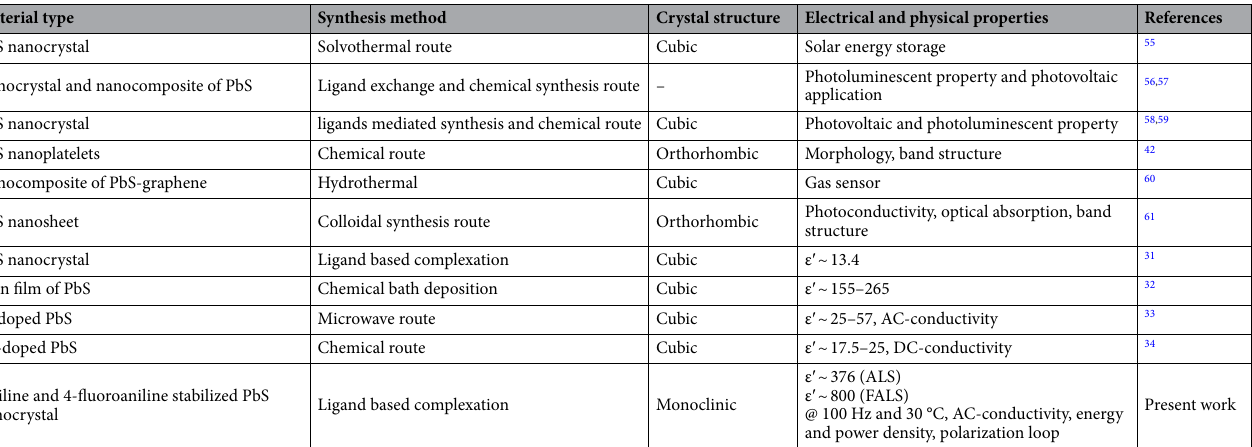
Table 1. The synthesis methodology, structure and physical properties of some of the reported lead sulfide based